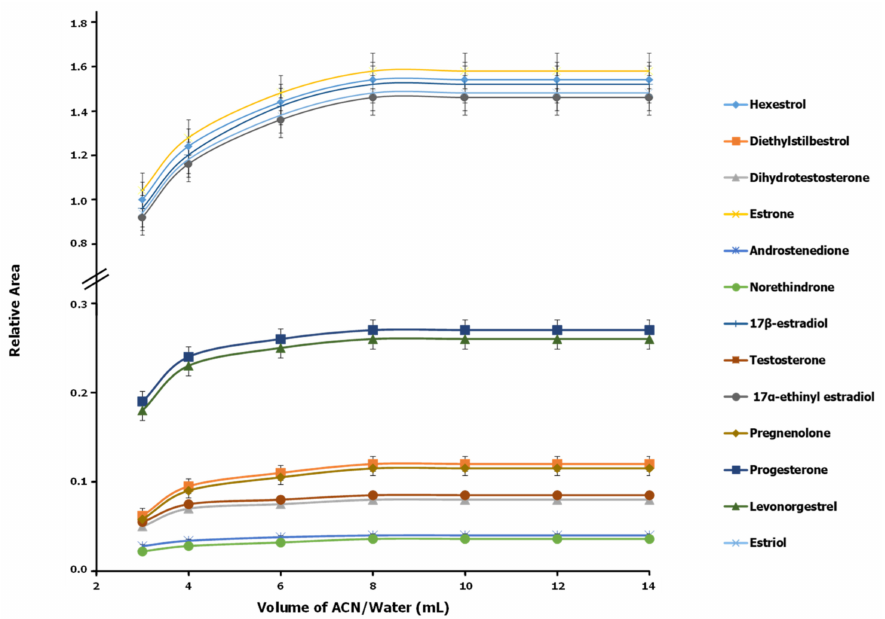
Figure 2. Influence of the volume of 9:1 v / v acetonitrile–water on the extraction of natural and synthetic hormones from meat (chicken breast) ( n =